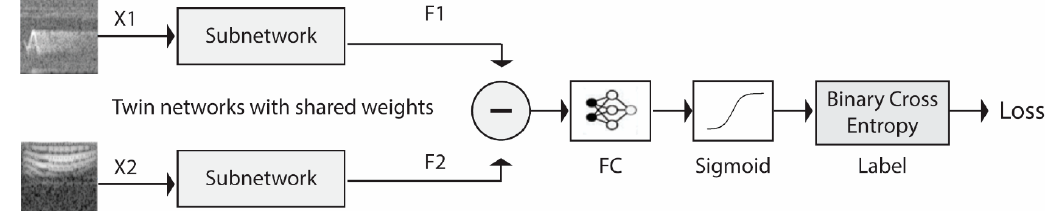
Figure 2. Siamese neural network architecture.